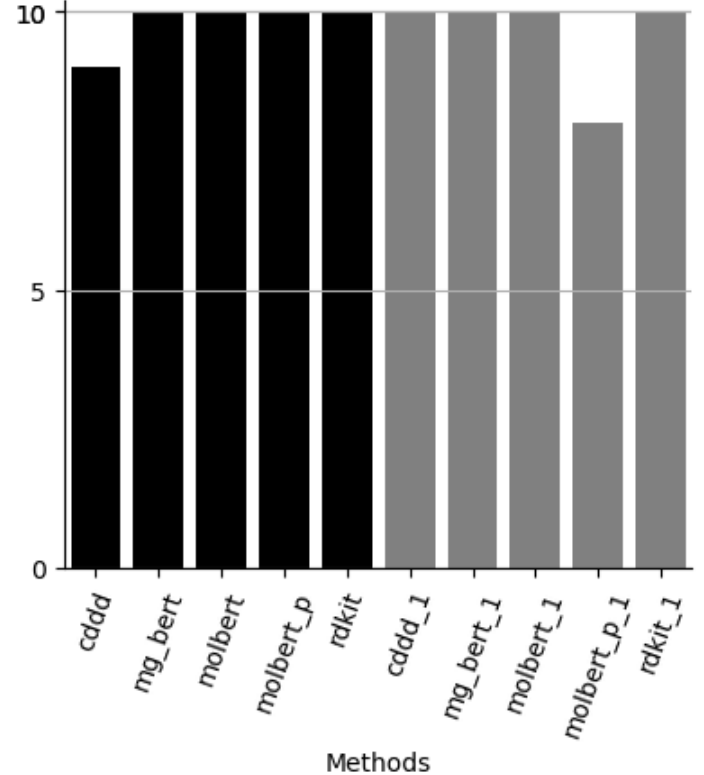
Figure 2. Number of valid evaluation set models (maximum 10) for each method type. Methods: cddd = RF/cddd 10 models, mg_bert = Molecular-graph-BERT/smiles 10 models, molbert = Mol- BERT/smiles 10 models, molbert_p = MolBERT/smiles 10 models with PubChem pre-trained model, rdkit = RF/rdkit 10 models, xxx_1 is the corresponding approach based on only 1 model.